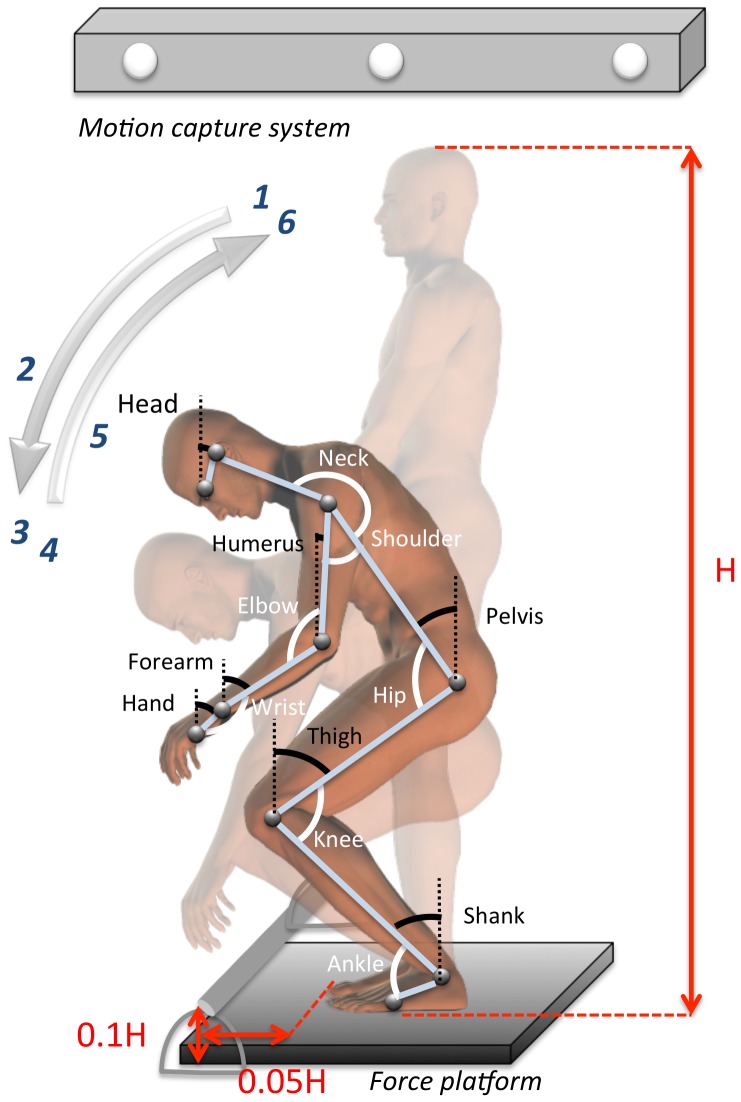
Experimental set-up.Segmental modeling and representation of inter-segmental angles and angles of elevation.